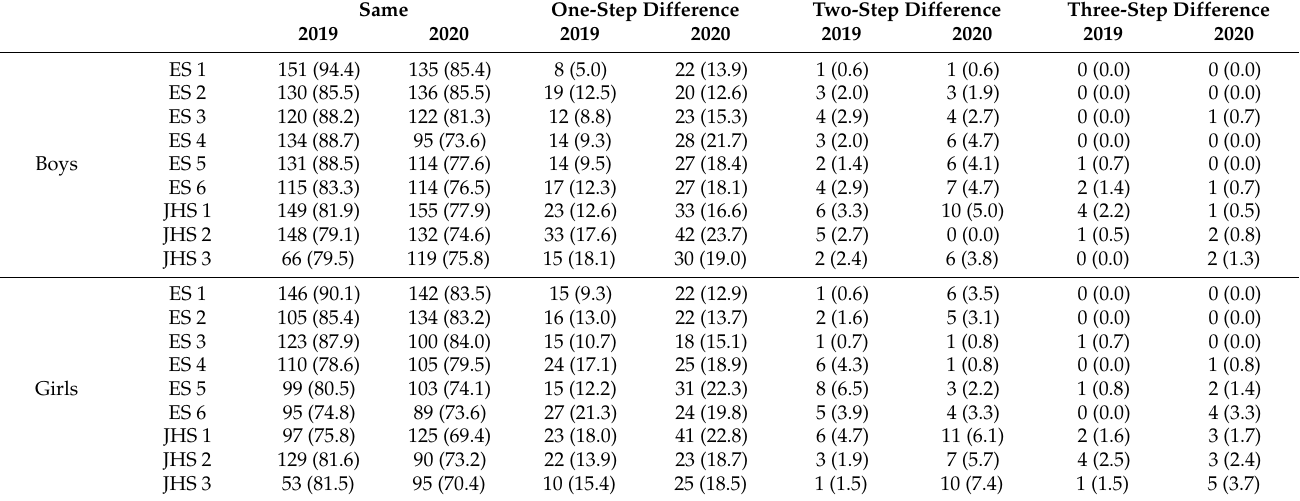
Table 3. Left-right difference in eyesight by sex and